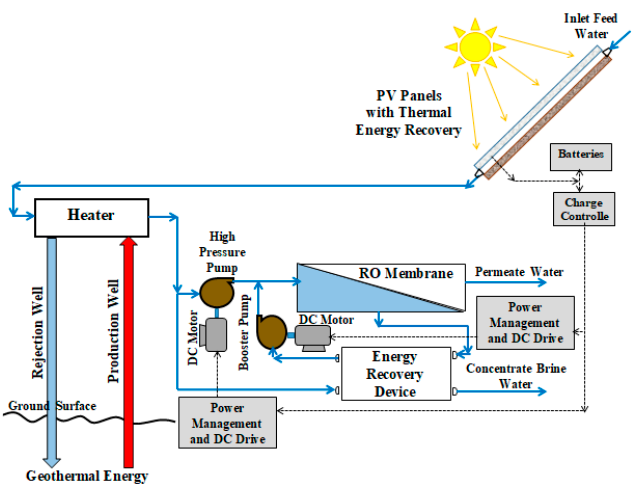
Figure 1. Simpli fi ed schematics of the proposed RO desalination